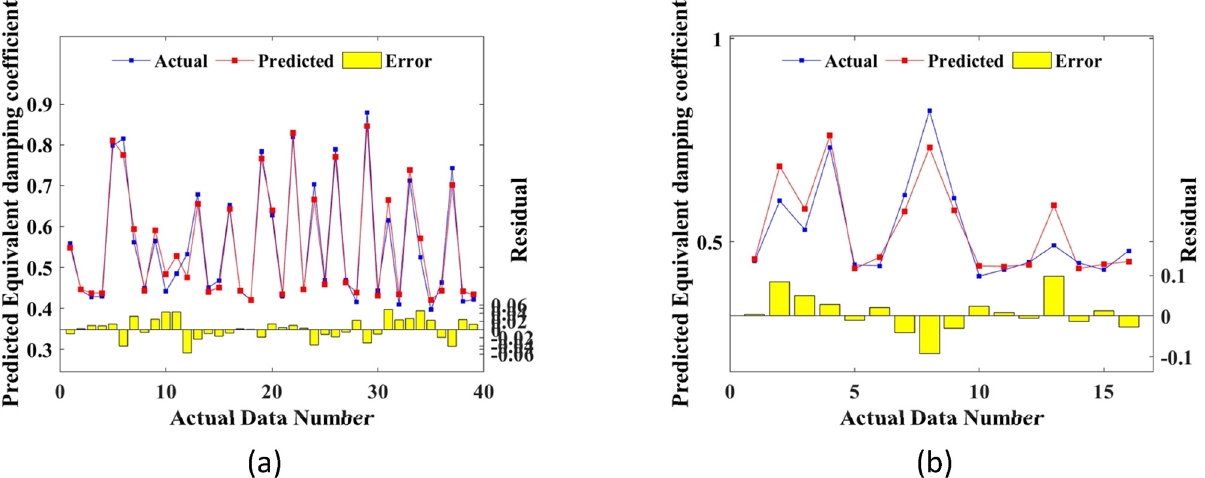
Figure 17: Scatter plot of simulated and actual equivalent damping coe ffi cient for training and test sets. ( a ) Training dataset. ( b ) Testing dataset.